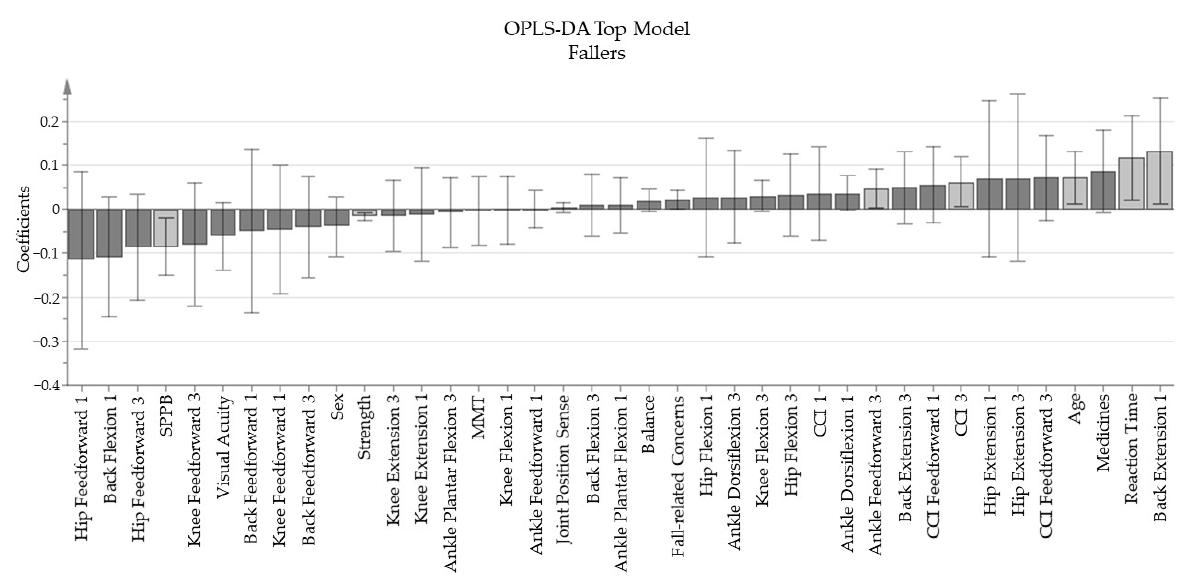
Figure 1. The coefficients of the final top model for the group “Fallers”. Bars to the left of the plot with a negative direction shows that fallers have lower values for those variables compared to the non-falling group; the opposite relations occur for the bars to the right with a positive direction. Variables with a significant weight to the model are indicated with a light grey bar.